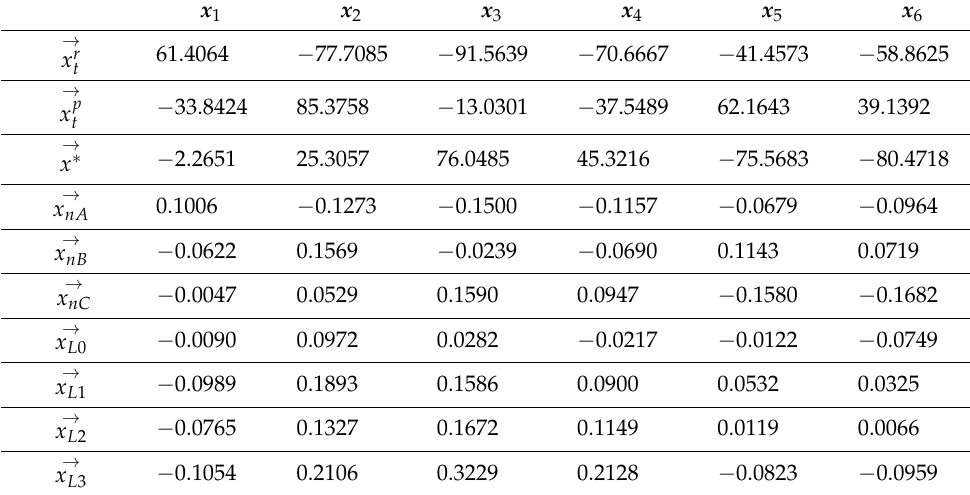
Table 2. An illustrative numerical example to the results generated according to Equations